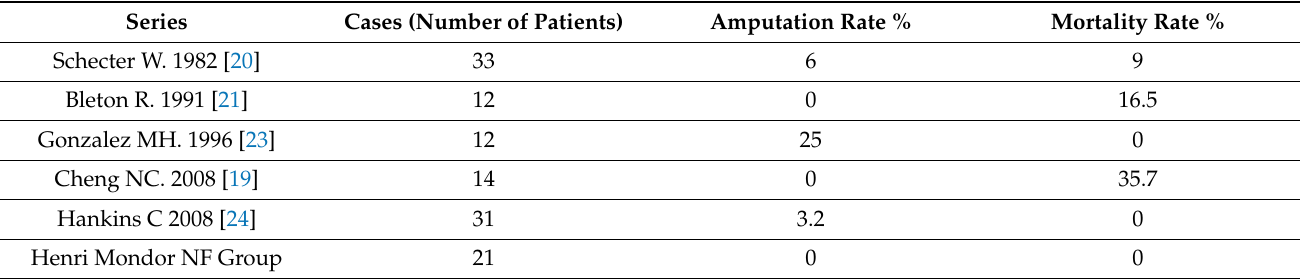
Table 3. Main series of NBDH-NF of the upper